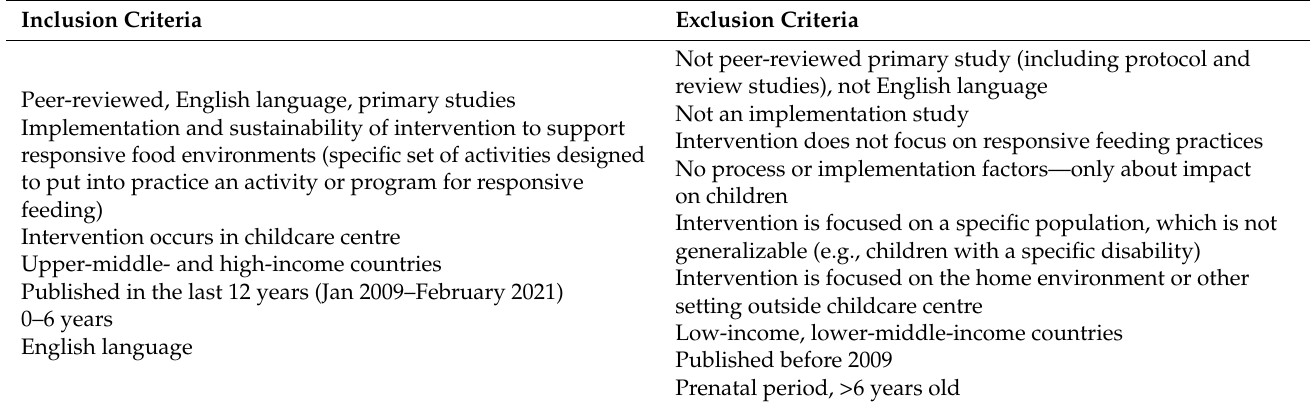
Table 1. Inclusion and exclusion criteria for the